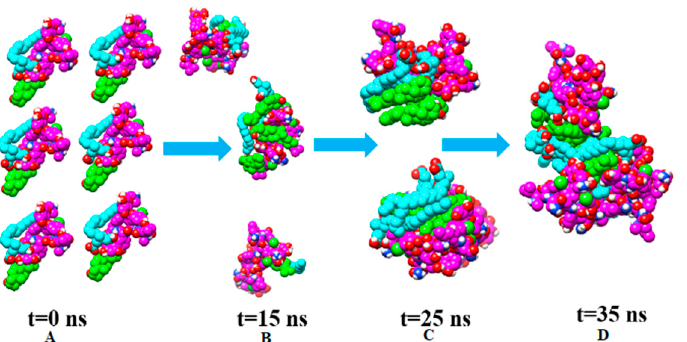
Figure 3. Self-assembly simulation at different points in time ( A – D ); where purple is VCM, green is CHol, and sky blue is StBAclm.